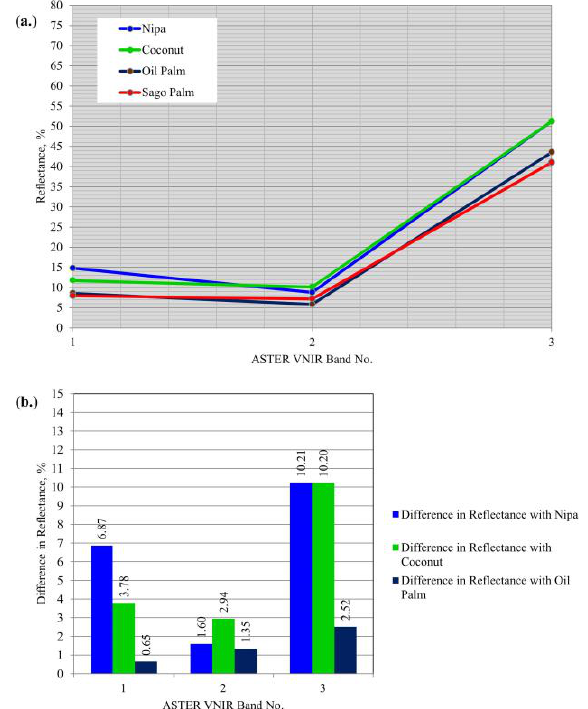
Figure 8. (a.) Resampled in-situ reflectance values of Sago and other palms in Bands 1-8 Worldview-2; (b.) Difference in resampled in-situ reflectance of Sago with those of other palms.